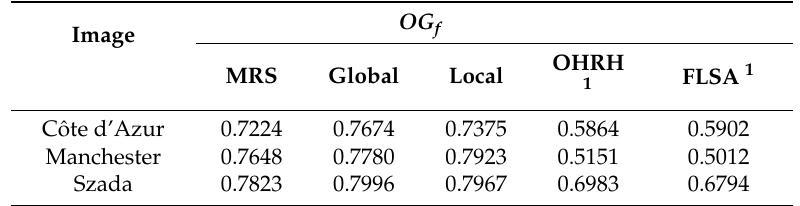
Table 1. The unsupervised evaluation results for the best segmentations of the SZTAKI-INRIA building detection dataset produced by MRS, Global, Local, OHRH, and FLSA methods.